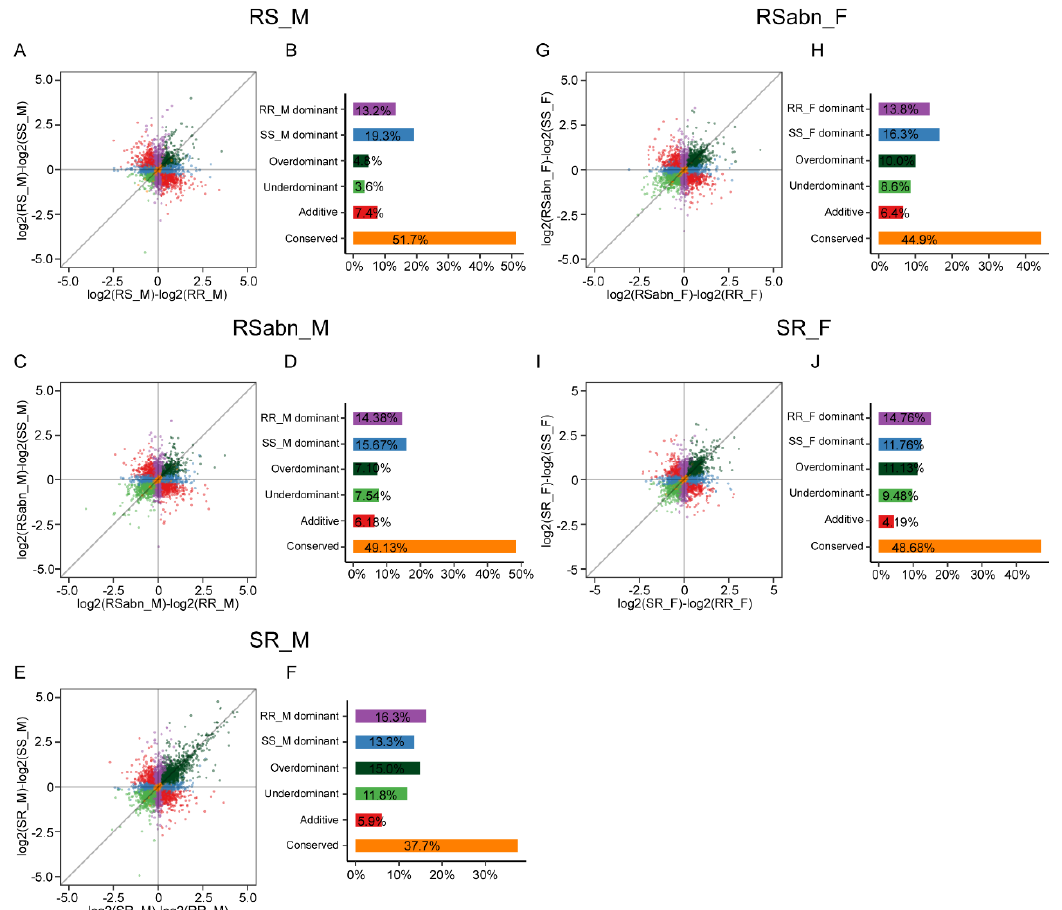
Figure 3. Inheritance modes of antennal gene expression in the five groups of F 1 hybrids of H. armigera and H. assulta . Scatterplot in panels ( A , C , E , G , I ) illustrates the differences in expression level (log 2 (fold-change)) between F 1 hybrids and each of the parental species. The X -axis represents the difference between RS_M and RR_M ( A ), RSabn_M and RR_M ( C ), SR_M and RR_M ( E ), RSabn_F and RR_F ( G ), and SR_F and RR_F (I); the Y -axis represents the difference between RS_M and SS_M ( A ), RSabn_M and SS_M ( C ), SR_M and SS_M ( E ), RSabn_F and SS_F ( G ), and SR_F and SS_F ( I ). Each point represents a single gene and is color-coded according to the inferred inheritance modes. Bar plots of panels ( B , D , F , H , J ) show the proportions of genes with different inheritance modes expressed in the antennae of RS_M ( B ), RSabn_M ( D ), SR_M ( F ), RSabn_F ( H ) and SR_F ( J ).